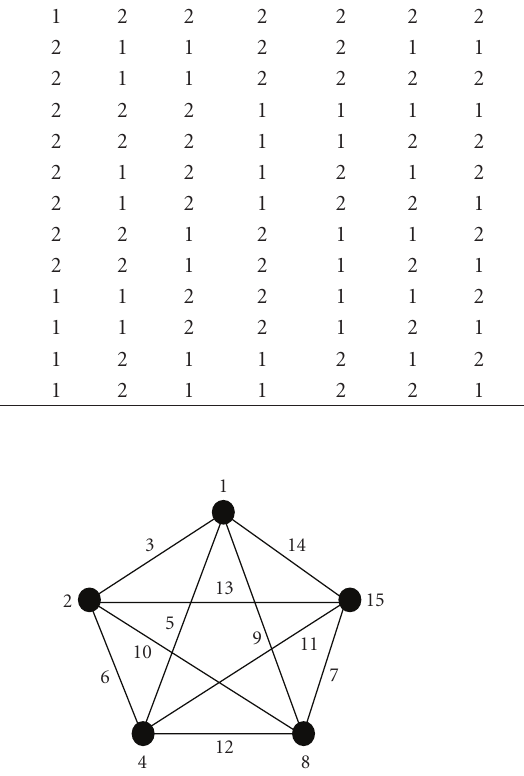
Figure 2: Linear graph associated with the orthogonal array L 16 (2 15